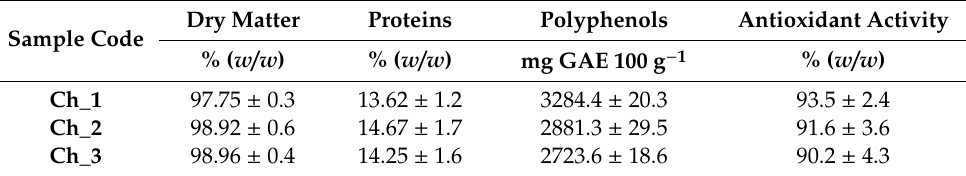
Table 4. Cocoa liquor—content: dry matter, protein, polyphenols, and antioxidant activity (code explanation in Table